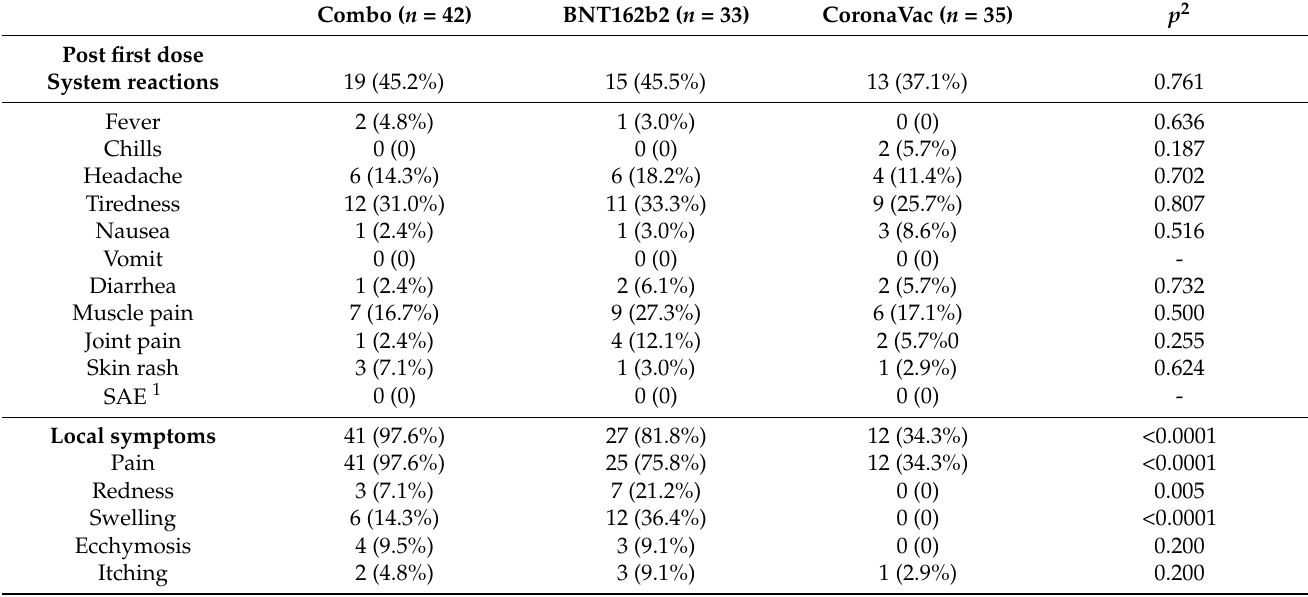
Table 4. Adverse